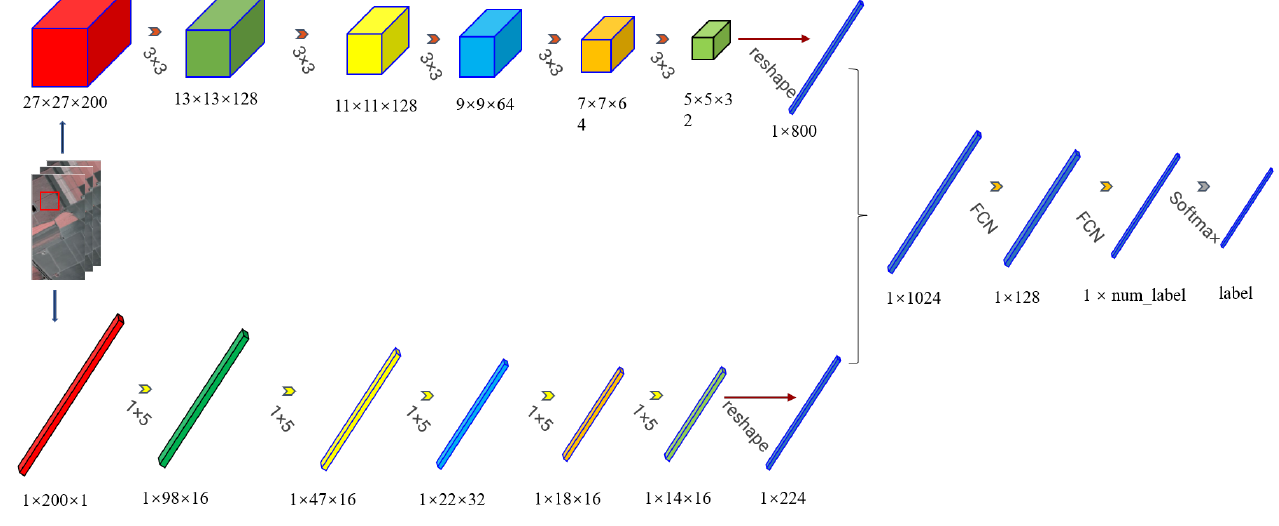
Figure 5. The structure of the classifier C .